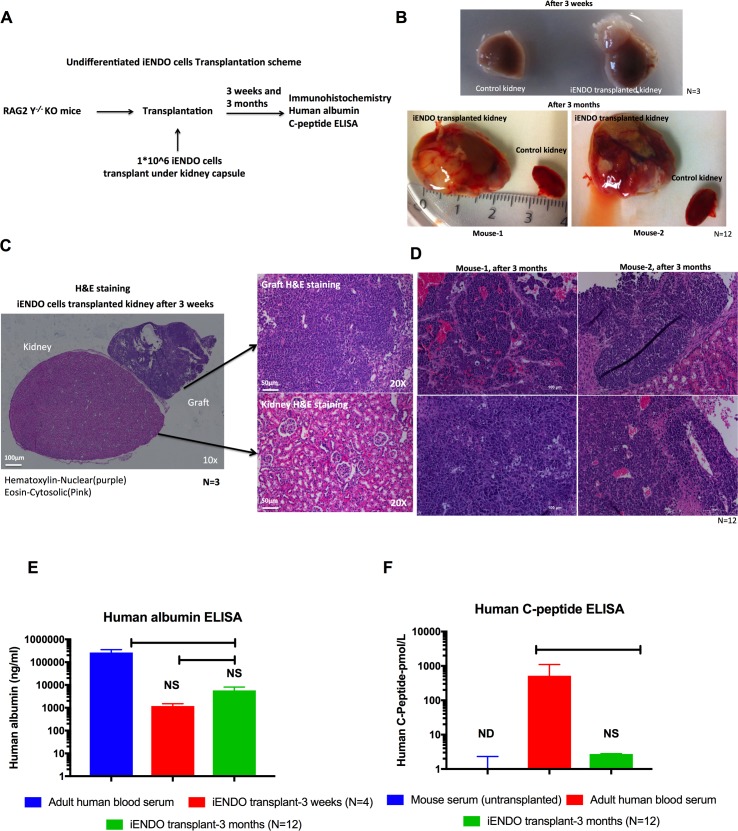
In vivo transplantation of 14TF iENDO cells under the kidney capsule forms endodermal tumors but that differentiate into hepatoblasts and pancreatic endocrine like cells.A) Schematic representation of transplantation of undifferentiated iENDO cells under the kidney capsule of RAG2-/- γc-/- mice. B) Morphology of control kidney (half portion shown) and iENDO cell grafted kidney after three weeks (N = 3) and after three months (N = 12). C) H&E stained sections of iENDO graft (10x and 20x magnification) 3 weeks after transplantation (scale bar 50μm) (N = 3). D) H&E stained sections of iENDO graft (20x magnification) 3 months after transplantation (mouse 1 and mouse 2)(scale bar 100μm) Representative for (N = 12) mice. E) Human albumin quantification by ELISA from iENDO cell grafted mice 3 weeks (N = 3) and 3 months (N = 12) after transplantation, untransplanted mouse serum and human blood serum. F) Human C-peptide by ELISA (untransplanted mouse serum, adult human blood serum and 14TF iENDO grafted mouse 3 months after transplantation (N = 12). *p<0.05, **p<0.01 and ***p<0.001 determined by unpaired 2-tailed Student’s t-test. ND- Not determined, NS- Not significant.